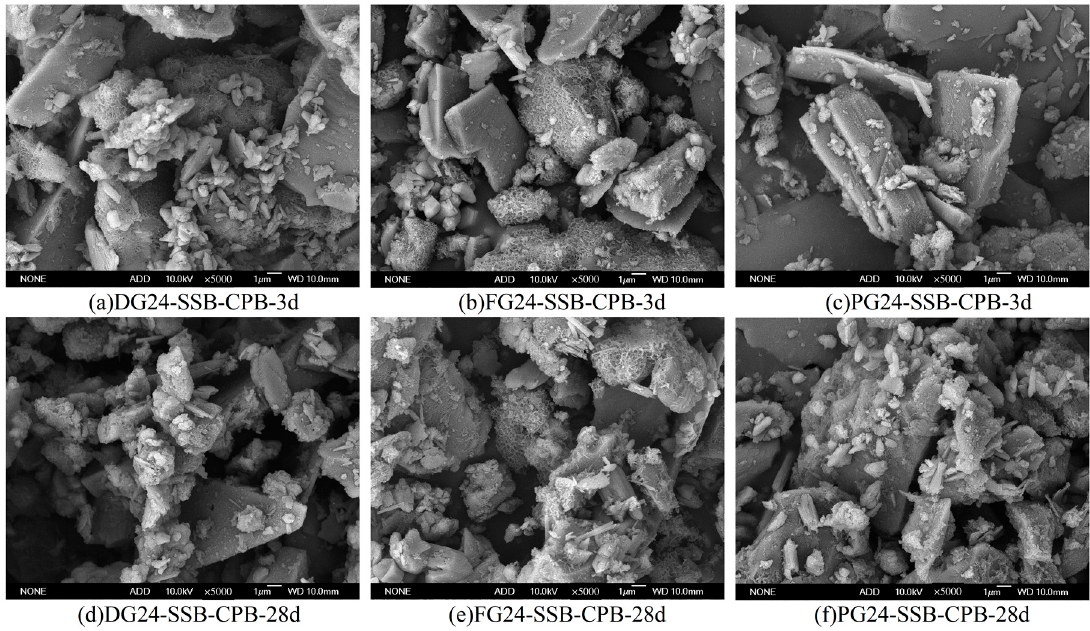
Figure 10. SEM micrographs of hardened SSB-CP with di ff erent gypsums: ( a ) DG24-SSB-CPB-3d, ( b ) FG24-SSB-CPB-3d, ( c ) PG24-SSB-CPB-3d, ( d ) DG24-SSB-CPB-28d, ( e ) FG24-SSB-28d, and ( f ) PG24-SSB-CPB-28d.